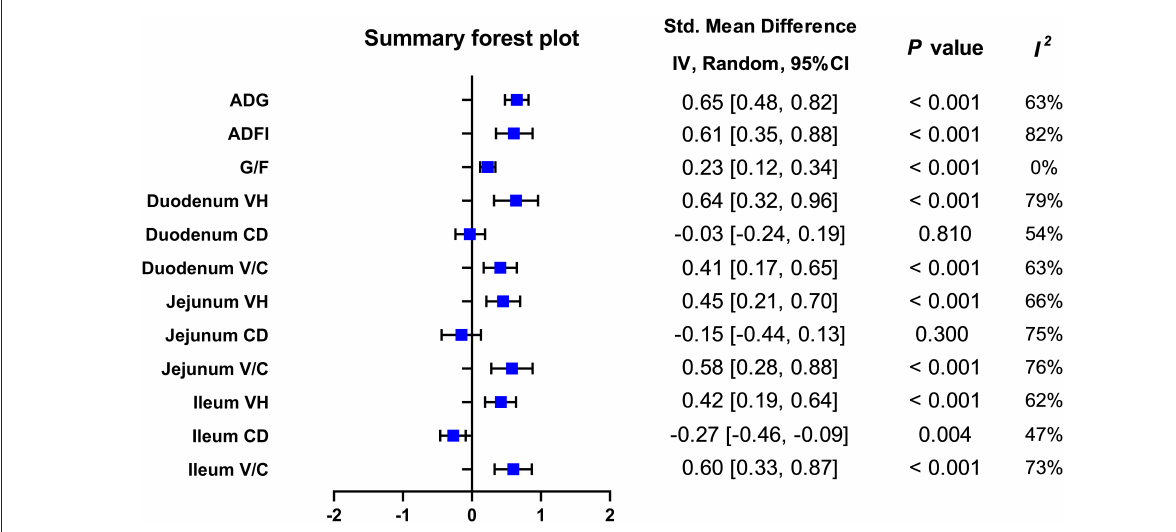
FIGURE2 Summary forest plot of included outcomes on pigs. ADG, average daily gain; ADFI, average daily feed intake; CI, confidence interval; G/F, gain: feed ratio; V/C, villus height: crypt depth